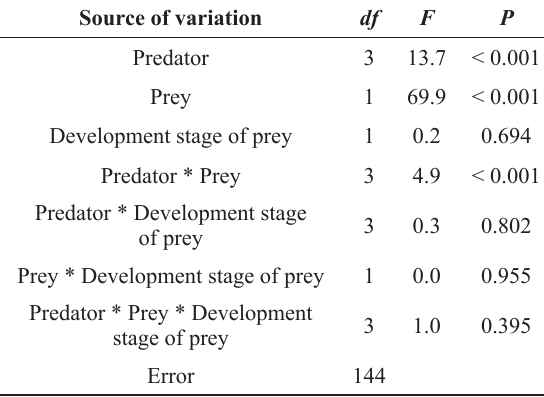
Analysis of variance of the effects of predator species, prey species and development stage on the predation rate of Cycloneda sanguinea, Eriopis connexa , Coleomegilla quadrifasciata and Orius insidiosus on Chaetosiphon fragaefolii and Aphis gossypii